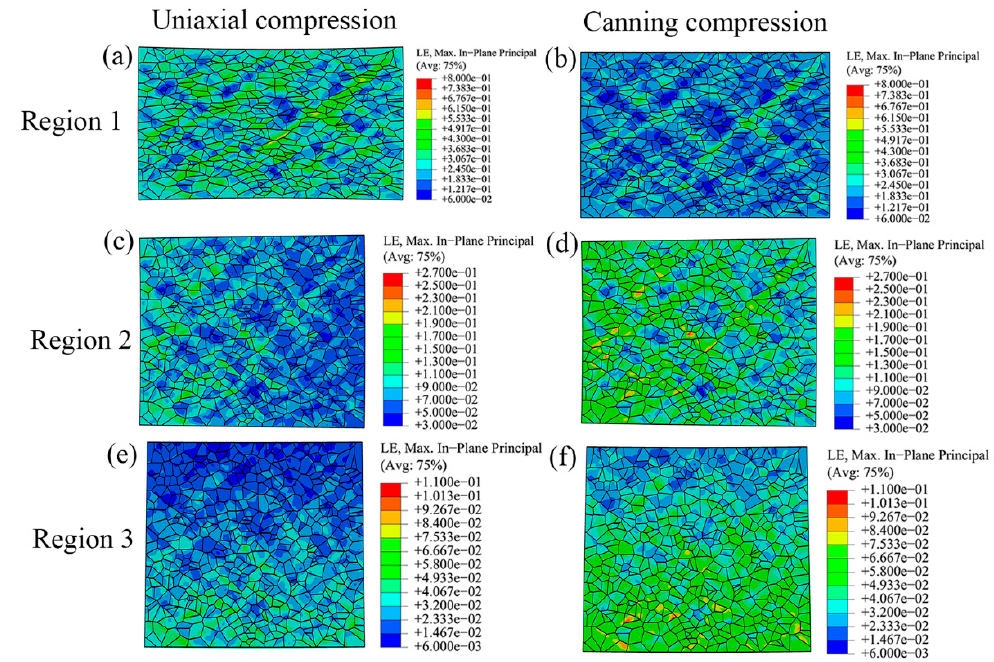
Figure 5. Strain distribution at the microscale level during uniaxial compression and canning compression processes with the locations of the polycrystalline models corresponding to regions 1, 2, and 3 in Figure 4.